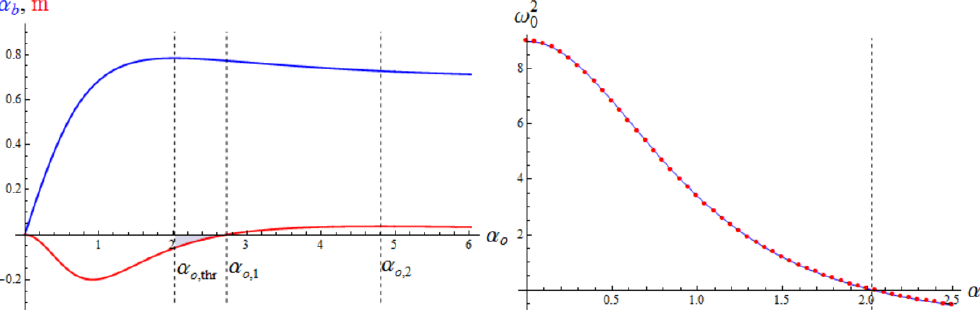
Figure 2 . Left: (cid:11) b (blue) and energy density (red) of the pumping solution in terms of (cid:11) o . The left dashed line corresponds to the maximum for (cid:11) b (to clarify the notation we recall that (cid:11) b; max = (cid:11) b ( (cid:11) o; thr ) where (cid:11) b is the function plotted in blue). The central dashed line corresponds to (cid:11) o = (cid:11) o; 1 below which the total mass is negative. The right dashed line corresponds to (cid:11) o = (cid:11) o; 2 where the total mass attains its maximum value. The shaded region corresponds to the linearly unstable pumping solutions of negative energy density. Right: frequency of the fundamental mode of a linear radial (cid:13)uctuation of the pumping solution. The linear instability threshold (cid:11) o; thr is signaled by the dashed vertical